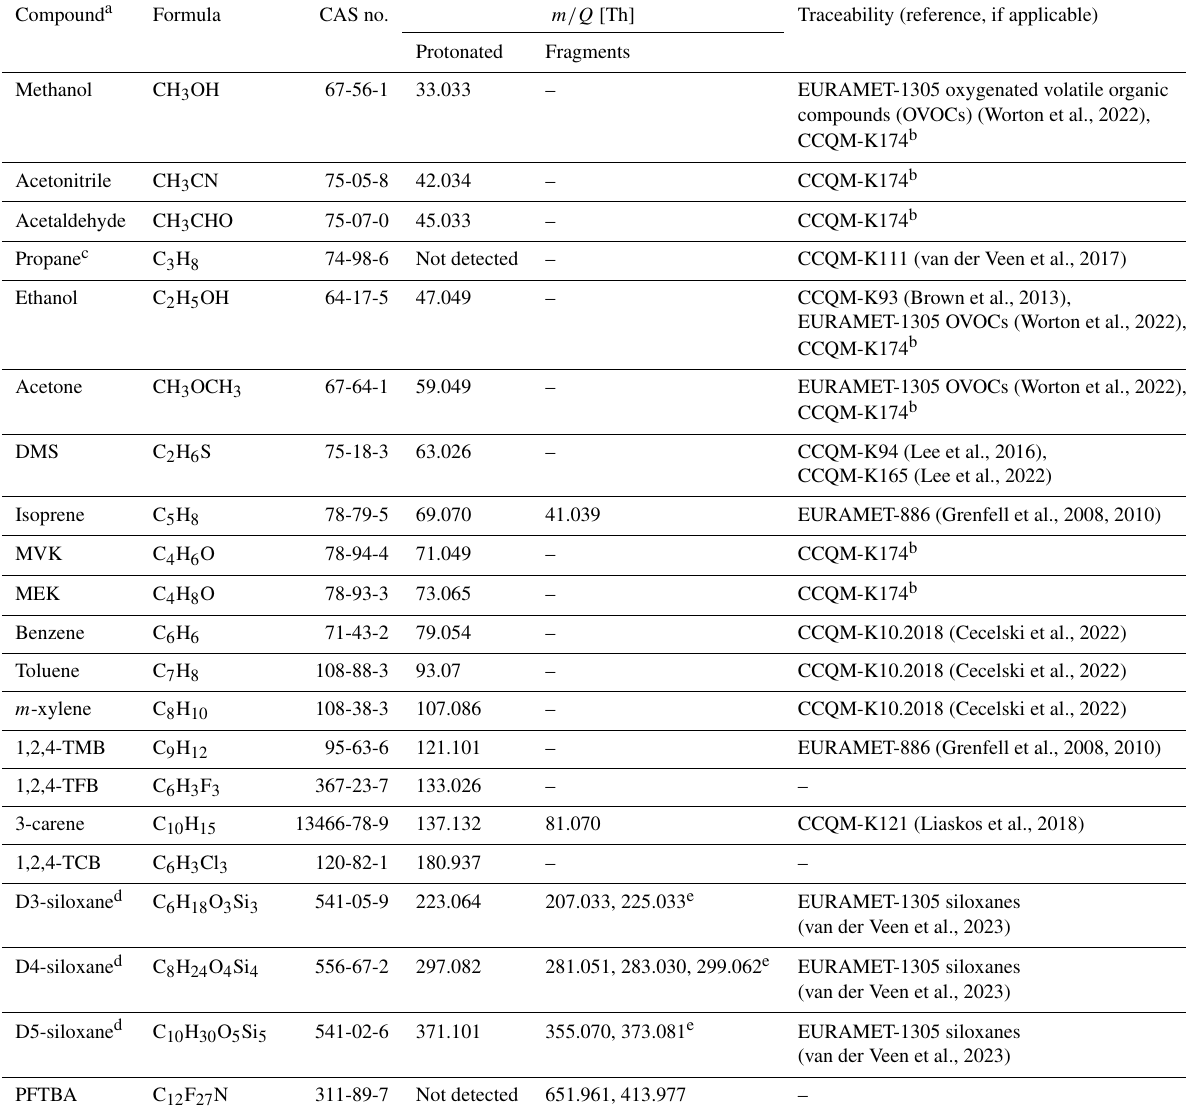
Table 1. Overview of the composition (name, formula, CAS no.) and the protonated monoisotopic molecular ion and any major fragment ions ( m/Q [Th]), formed following protonation in H 3 O + mode, for 20 compounds included in the PRMs and CRMs and the key comparisons through which the traceability to the international community is